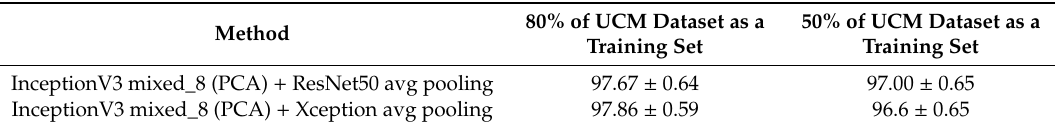
Table 5. The overall accuracy (%) and standard deviation of the examined method, with 80% and 50% of the UC-Merced dataset as a training